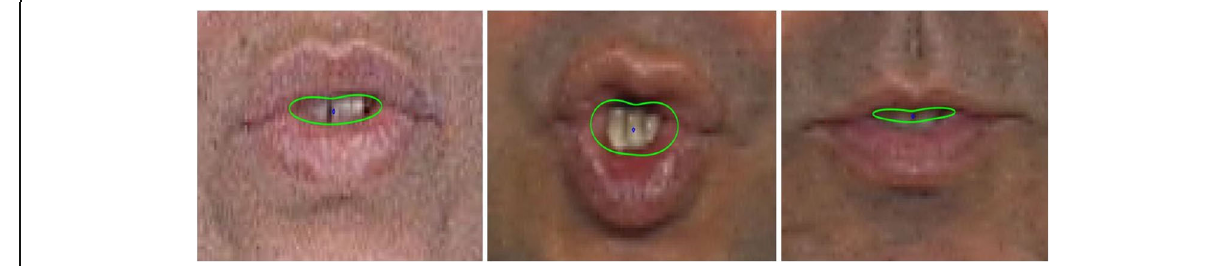
Fig. 16 The green curve is the whole inner lips contour for round open lips by the proposed periodical spline